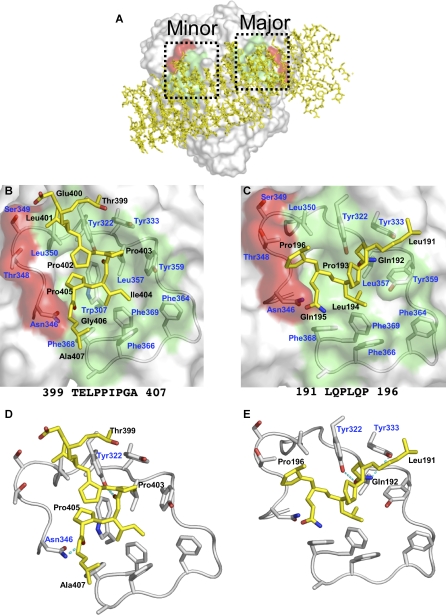
Mtd-P1 Receptor-Binding Sites(A) The Mtd-P1·Prn-E complex is depicted with Mtd-P1 in molecular surface representation and Prn-E in yellow stick representation. The view is looking at the base of the pyramid-shaped Mtd trimer. The surfaces of the Mtd sites that bind the major and minor pertactin loops are colored (green, hydrophobic residues; red, hydrophilic residues).(B) Contacts between Mtd-P1 and the major pertactin loop. Mtd-P1 is depicted in molecular surface representation, as in (A). Backbone atoms of the Mtd-P1 variable region are depicted in gray curvilinear representation, and side chain carbons, oxygens, and nitrogens in gray, red, and blue, respectively. Mtd-P1 residues are labeled in blue. The major loop of Prn-E (residues 399–407, sequence below panel) is depicted in stick representation (backbone in yellow and side chain carbons, oxygens, and nitrogens in yellow, red, and blue, respectively). Prn-E residues are labeled in black. The backbone carbonyls of Prn-E Pro403 and Pro405 are also depicted.(C) Contacts between Mtd-P1 and the minor pertactin loop, depicted as in (B).(D and E). Hydrogen bonds to (D) major and (E) minor pertactin loops are shown as cyan dashed lines. Atom coloring is as in panels (B) and (C).